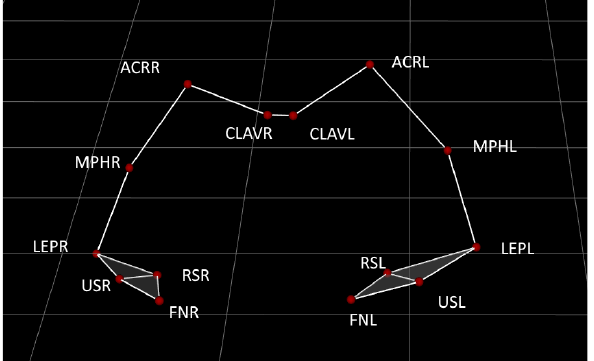
Fig. 1. Upper body marker placement schema. Markers were located on both upper limbs (right R/L left), CLAVR/L – cla- vicular heads, ACRR/L – acromion process, MPHR/L – middle part of the humeri, LEPR/L – lateral epicondyle, RSR/L – ra- dial styloid, USR/L – ulnar styloid, FNR/L – index finger